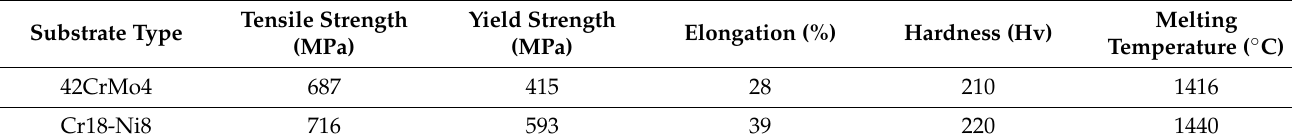
Table 3. Mechanical properties of the substrates used for additive manufacturing.